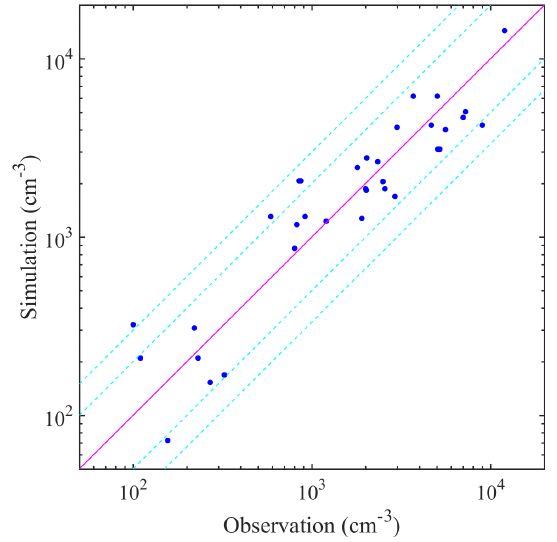
Figure 8. Comparison of simulated and observed annual mean num- ber concentrations of particle condensation larger than 10nm at 34 sites listed in Table S1. The solid carmine line shows a 1 : 1 ratio and the dashed turquoise lines show ratios of 3 : 1, 2 : 1, 1 : 2, and 1 :